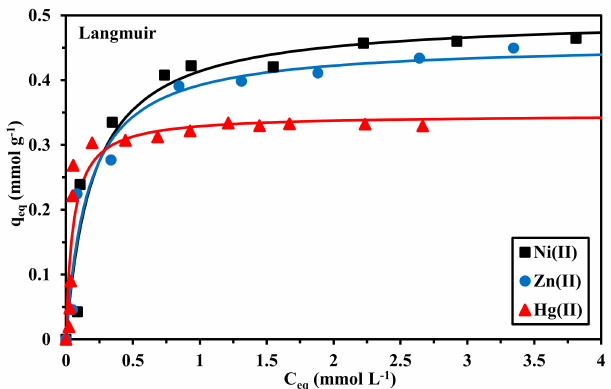
solutions—modeling with the Langmuir equation (C 0 : 0.3 mmol L − 1 ; pH 0 : 5.5; pH eq : 5.75 (Ni), 5.80 (Zn), and 6.01 (Hg); sorbent dose, SD: 1 g L − 1 ; T: 21 ± 1 ◦ C; time: 60 min; agitation speed: 150